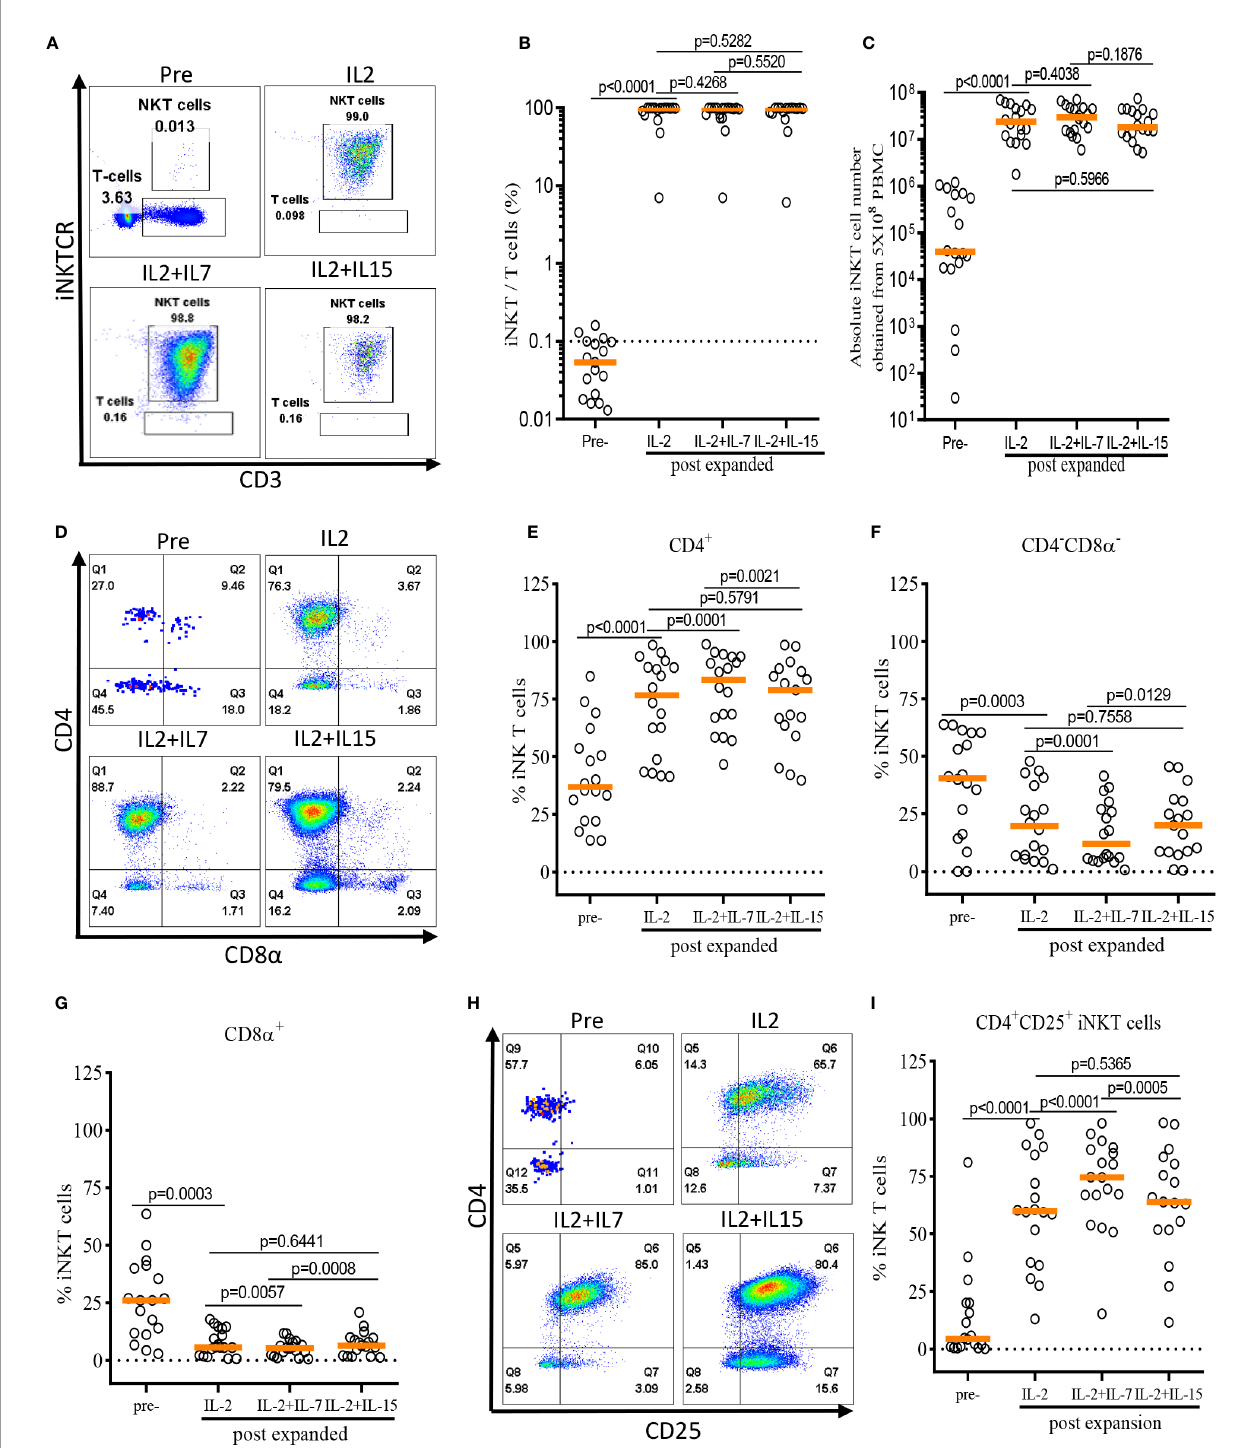
FIGURE 3 | IL-7 stimulation preferentially expands human CD4 + and CD4 + CD25 + iNKT cells. The iNKT cells were enriched from peripheral blood mononuclear cells (PBMCs) via anti-iNKT microbeads/MACS separation and subsequently co-cultured with allogeneic dendritic cells (DCs) in presence of a GalCer and growth factors (IL-2, IL-2+IL-7, or IL-2+IL-15) for 14 days. (A – C) Representative dot-plot fl ow cytometry analysis, purity, and absolute number of iNKT cells in pre- and post- expansion. (D – G) Representative fl ow cytometry analysis and the percentage of CD4 + , CD8 a + , and CD4 - CD8 a - iNKT cells in pre- and post-expansion. (H, I) Representative fl ow cytometry analysis of CD4 and CD25 on iNKT cells in pre- and post-expansion. Horizontal orange lines show median; p values are shown above each group. Each symbol represents a value from a single